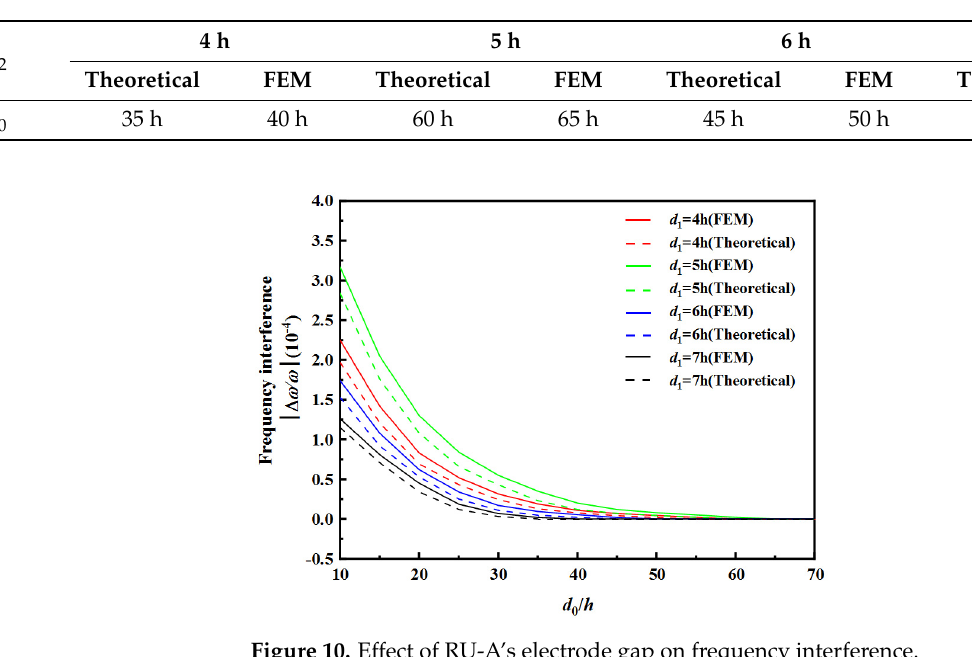
Table 5. The safe distance d 0 between the two resonator units with different electrode gap of RU-B.